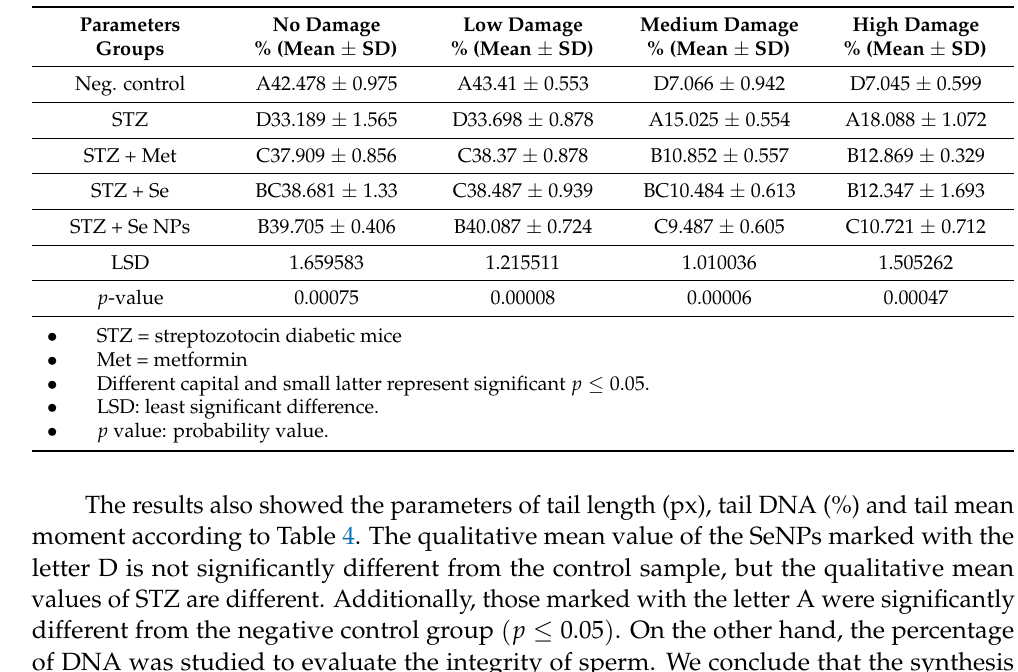
Table 3. The result of the comet assay in sperm after treatment with SeNPs.